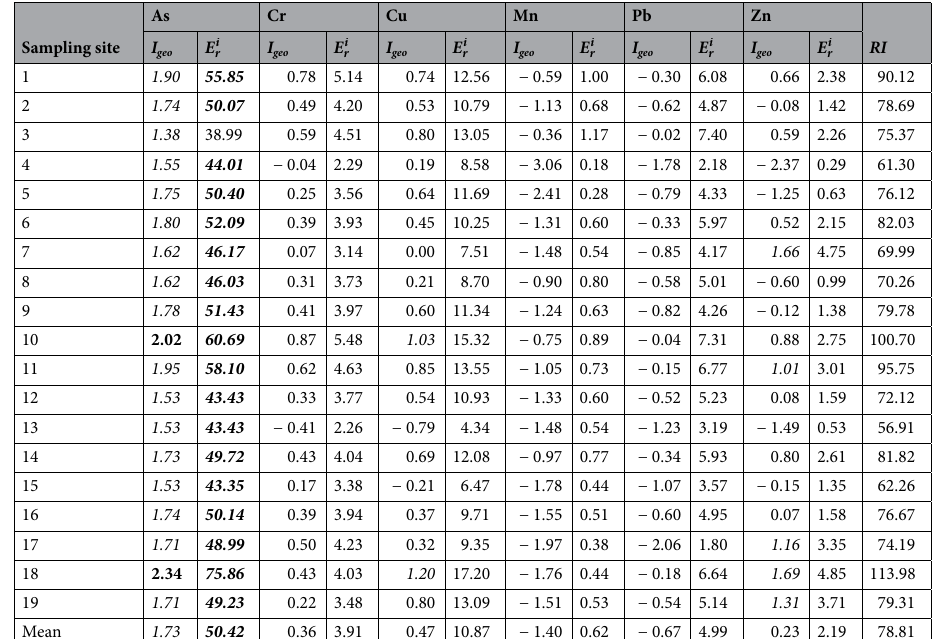
Table 5. The HM accumulation index, individual ecological risk coefficient and potential ecological risk index in surface sediments. The bold font indicates; when I geo is 2–3, moderate pollution; italic font indicates; when I geo is 1–2, near moderate pollution and; the bolditalic font indicates; the E